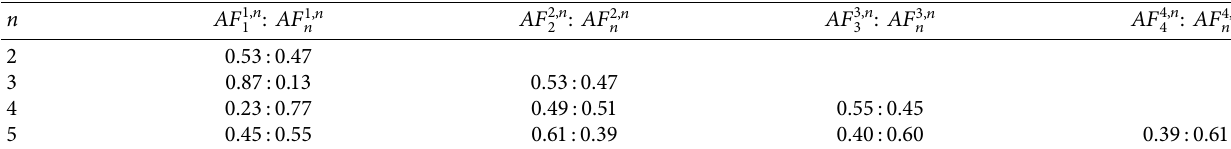
Table 19: Belief distribution coefficient of each intersection belief.